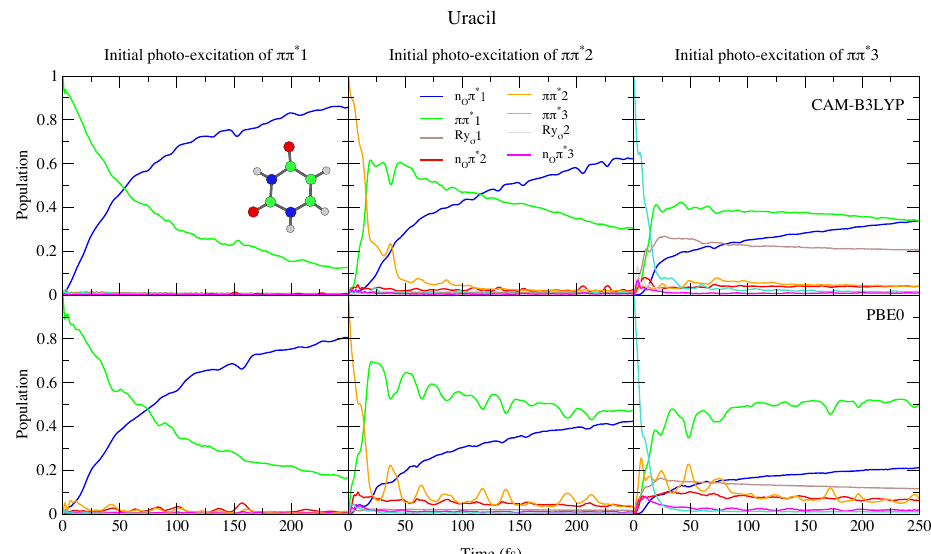
Figure 4. Nonadiabatic dynamics of electronic populations of Uracil in the gas phase, as predicted by an LVC Hamiltonian parameterised with calculations at the FC point using CAM-B3LYP ( top ) and PBE0 ( bottom ) functionals with a 6-311+G(d,p) basis set.